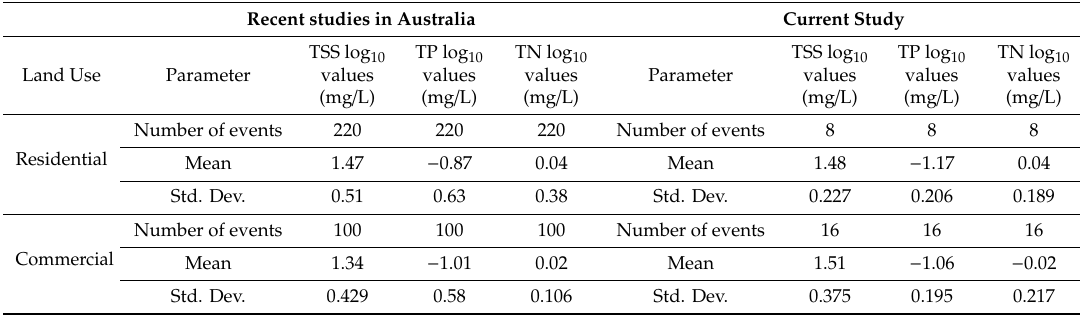
Table 3. Comparison of log-transformed EMCs for residential and commercial areas in South-East Queensland Australia [17] and